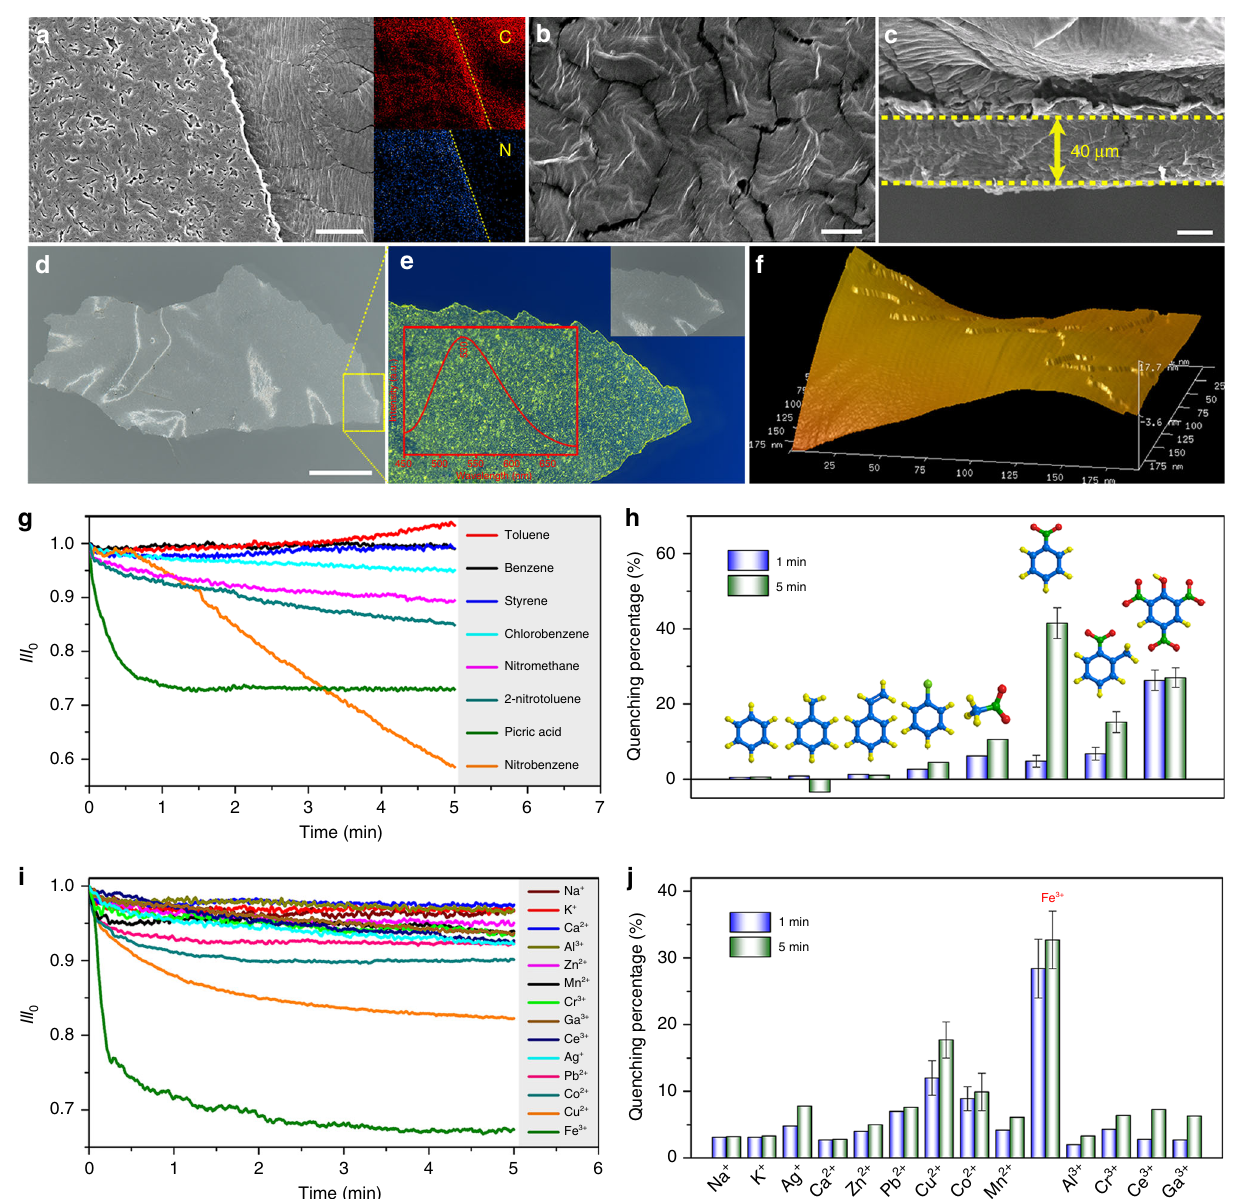
Fig. 6 Chemical sensing by MMMs containing NUS-24 nanosheets. a , b FE-SEM and EDX elemental mapping (carbon and nitrogen) images of the MMMs (scale bar, 50 μ m in a and 5 μ m in b ). c Cross-sectional FE-SEM image of the MMMs (scale bar, 20 μ m). d , e Optical ( d ) and fl uorescence ( e ) photographs of the MMMs (scale bar, 5 mm in d . λ ex = 365 nm). f AFM image of the MMMs. g Time-dependent fl uorescence intensity changes ( I / I 0 ) of the MMMs upon 5 min exposure to VOCs vapors ( λ ex = 365 nm, λ em = 530 nm). h The quenching percentages of the MMMs by VOC vapors after 1 and 5 min exposure. i Time-dependent fl uorescence intensity changes ( I / I 0 ) of the MMMs upon 5 min exposure to metal ion solutions ( λ ex = 365 nm, λ em = 530 nm). j The quenching percentages of the MMMs by metal ions after 1 and 5 min exposure. The error bars in h and j show standard deviations based on